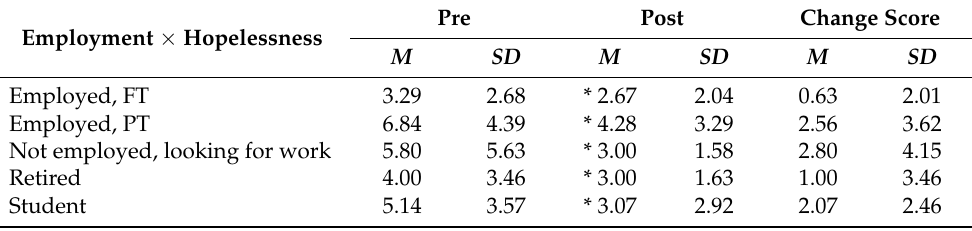
Table 3. Pre-post and change scores for interaction effect of Employment × Hopelessness (N = 79). Pre Employment × Hopelessness